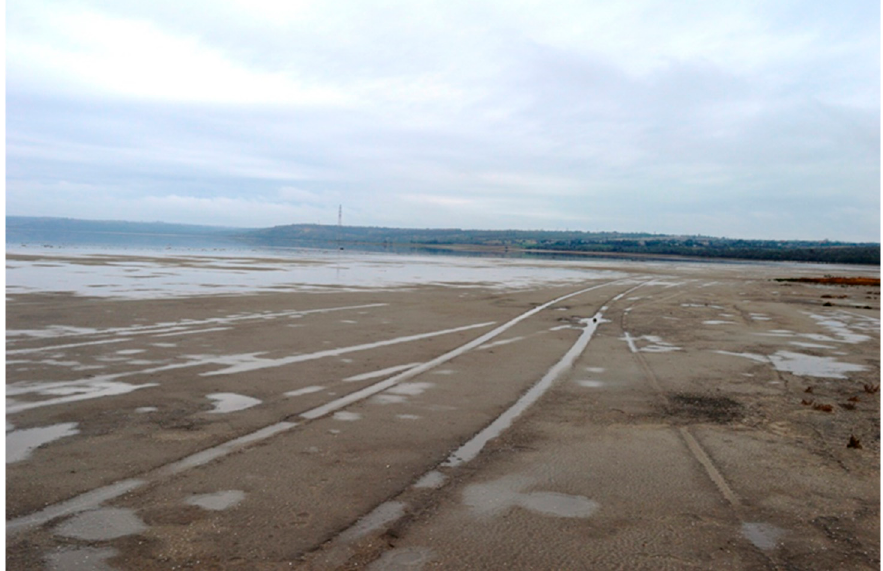
Figure 16. Seasonal roads on the coastal areas of Kuyalnik Estuary (surroundings of Kovalivka vil- lage).